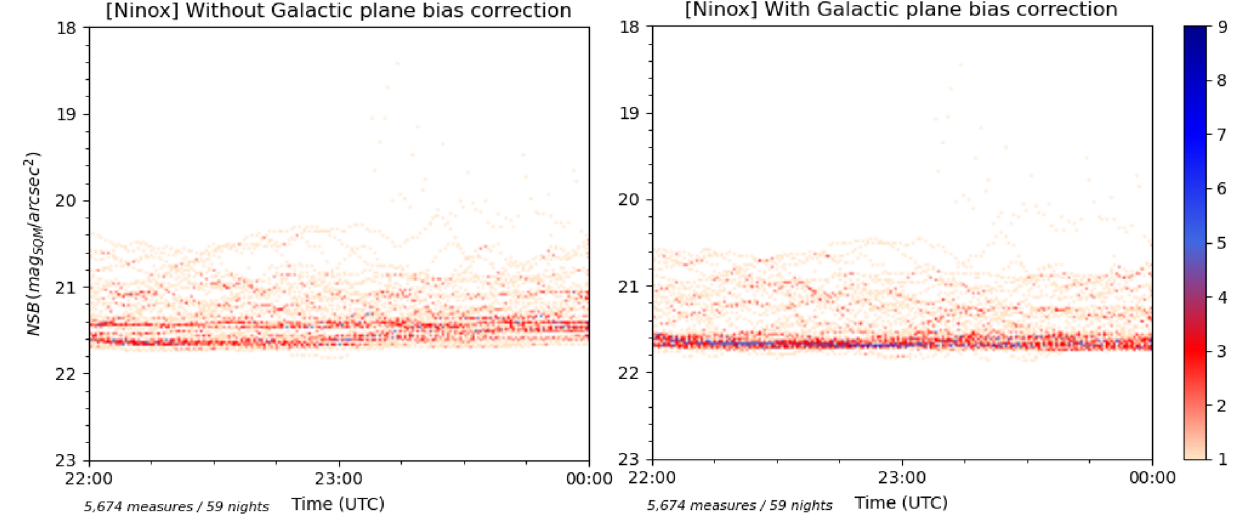
Figure 9. NSB density histograms of the same data set with no correction of the Galactic plane bias applied on the left and a full correction applied on the